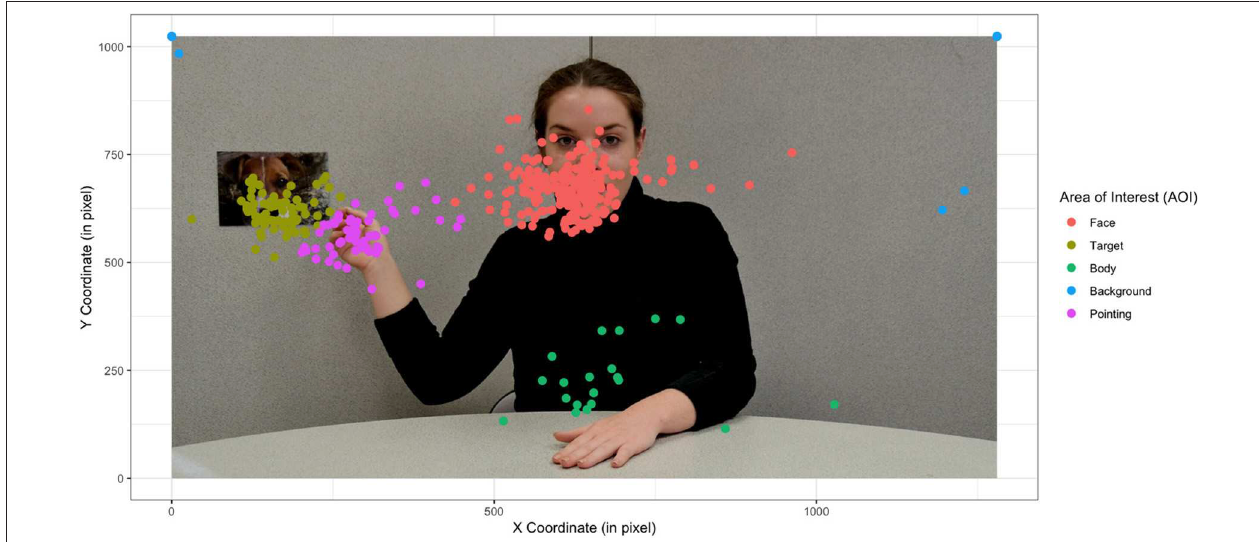
FIGURE 1 | Representation of fixation centroids independently of group and stimulus type (static vs. dynamic) during a joint attention bid involving a pointing action. The actress was informed and gave her written consent for scientific publication of her image.